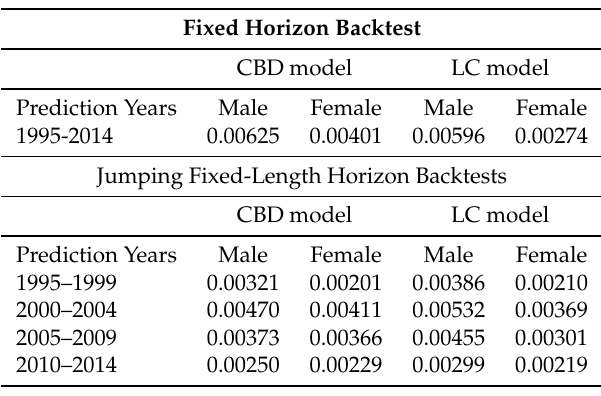
and forecast q P x , t x , t